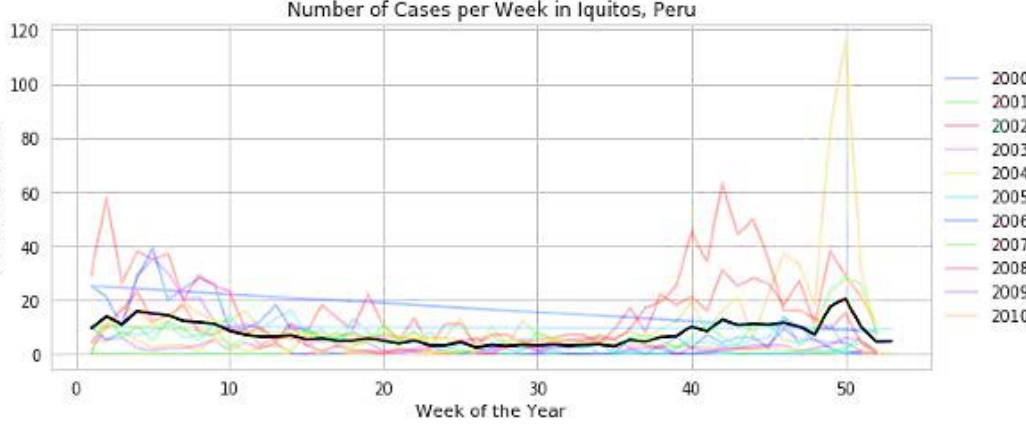
Figure 9. Increase in outbreaks and cases in Iquitos city of Peru in weeks.